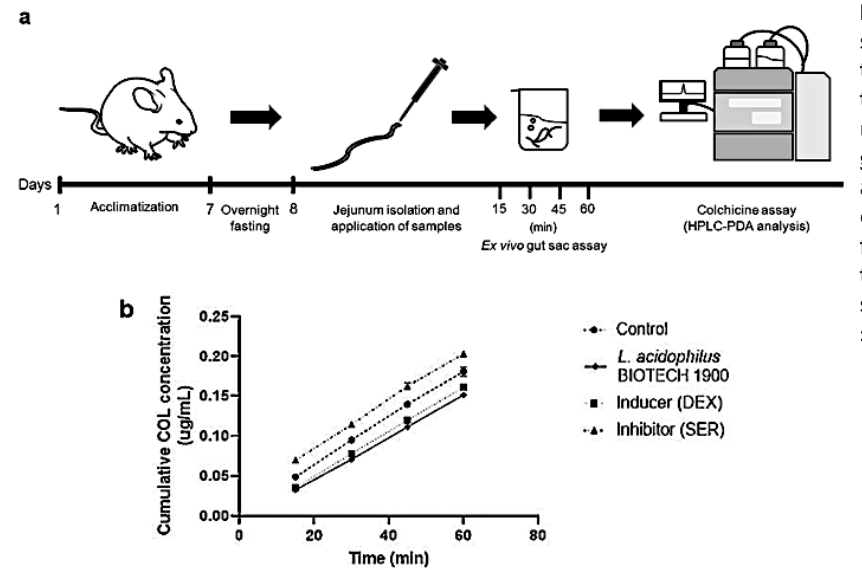
Figure 2. a. Summarized scheme for the transepithelial mucosal- to-serosal transport of COL using an ex vivo non-everted gut sac model and HPLC-PDA analysis. b. Cumulative COL concentrations measured from the serosal medium in the ex vivo non-everted gut sac model. Values are mean ± SD (n =